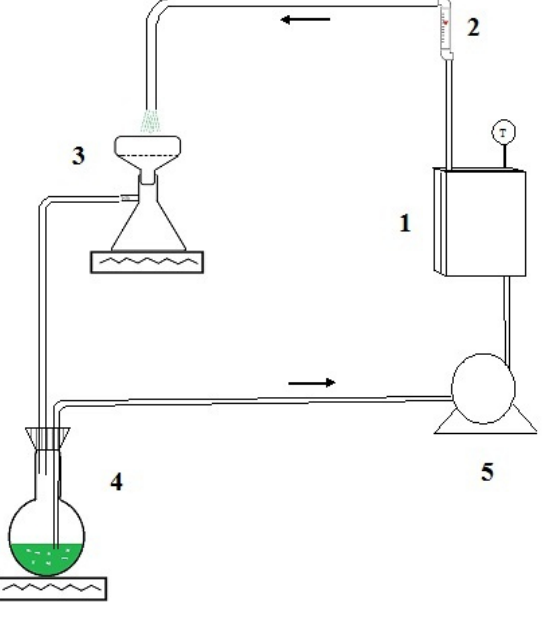
Figure 9. Experimental set up for parallel reactor tests. ( 1 ) Parallel-plate reactor; ( 2 ) rotameter; ( 3 ) filter flask with electric heat; ( 4 ) round bottom flask with stirring and electric heat; and ( 5 ) peristaltic